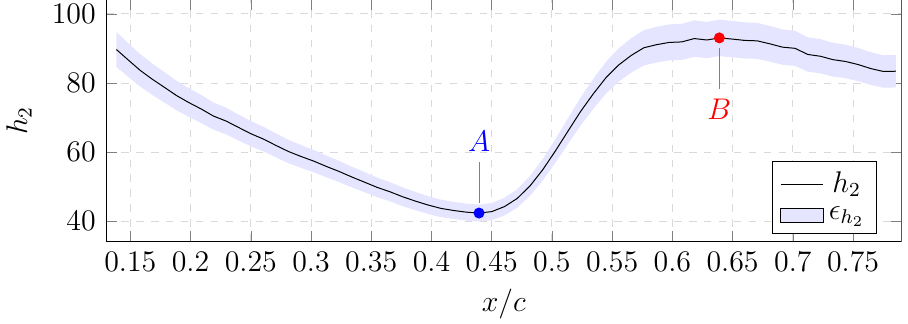
Figure 9. Chordwise distribution of air-side HTC and uncertainty at vane midspan for case φ =